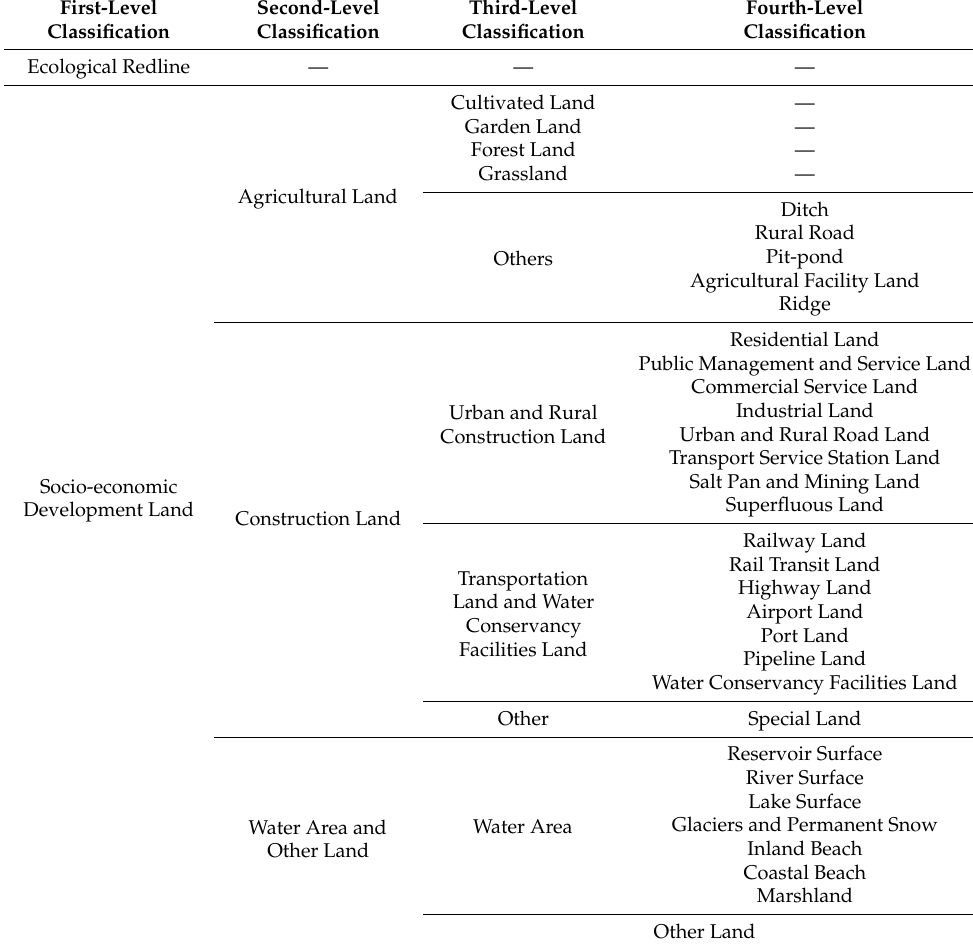
Table 2. Land classification standard for optimizing county-level land-use structure. First-Level